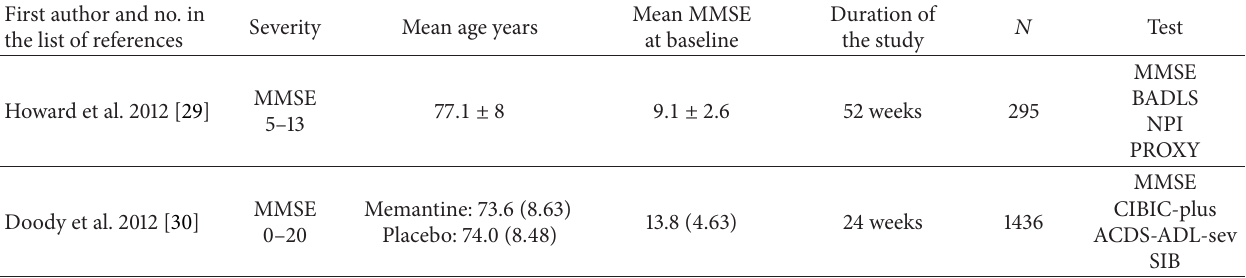
Table 5: Clinical trials characteristics and results of the association of donepezil plus memantine in moderate-severe